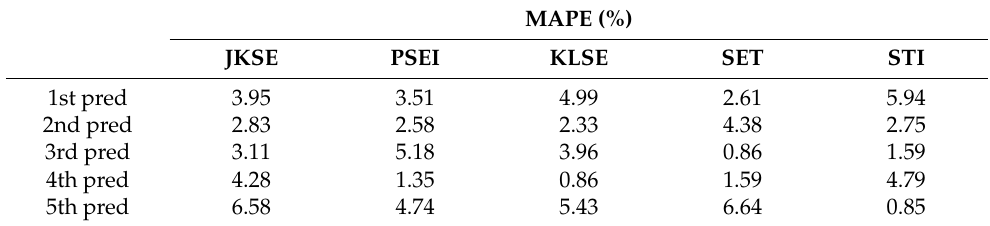
Table 6. MAPE values for GBM model predictions.